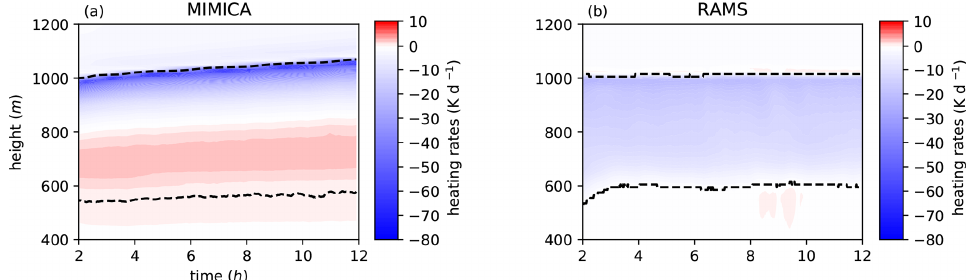
Figure 6. Radiative heating rates in the baseline simulation (AC20_AK20), simulated by (a) MIMICA and (b) RAMS. The first 2h of simulations, considered as the spin-up period, are excluded. Black dashed lines represent the cloud top and cloud base heights.